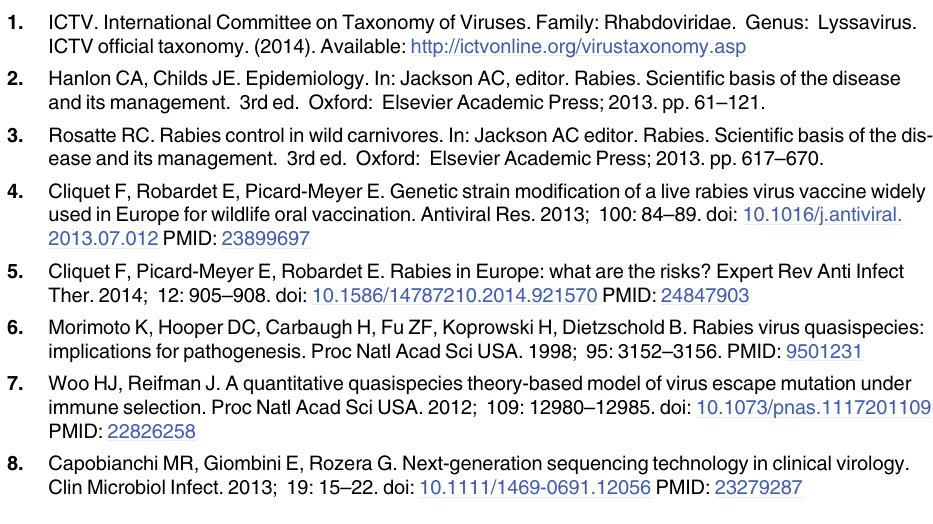
S1 Table. Percentage of variants using 454 pyrosequencing in comparison to reference SAD Bern sequence, GenBank acc. n. EF206708, including coverage for each position expressed by number of reads per position. S2 Table. Percentage of variants using Illumina RNA sequencing in comparison to refer- ence SAD Bern sequence, GenBank acc. n. EF206708, including coverage for each position expressed by number of reads per